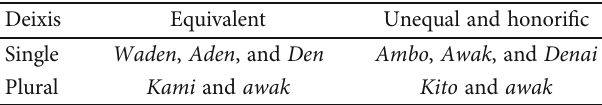
Table 3: Deixis of female fi rst-person pronouns in Pasar Bawah Bukittinggi. Deixis Equivalent Waden , Aden , and